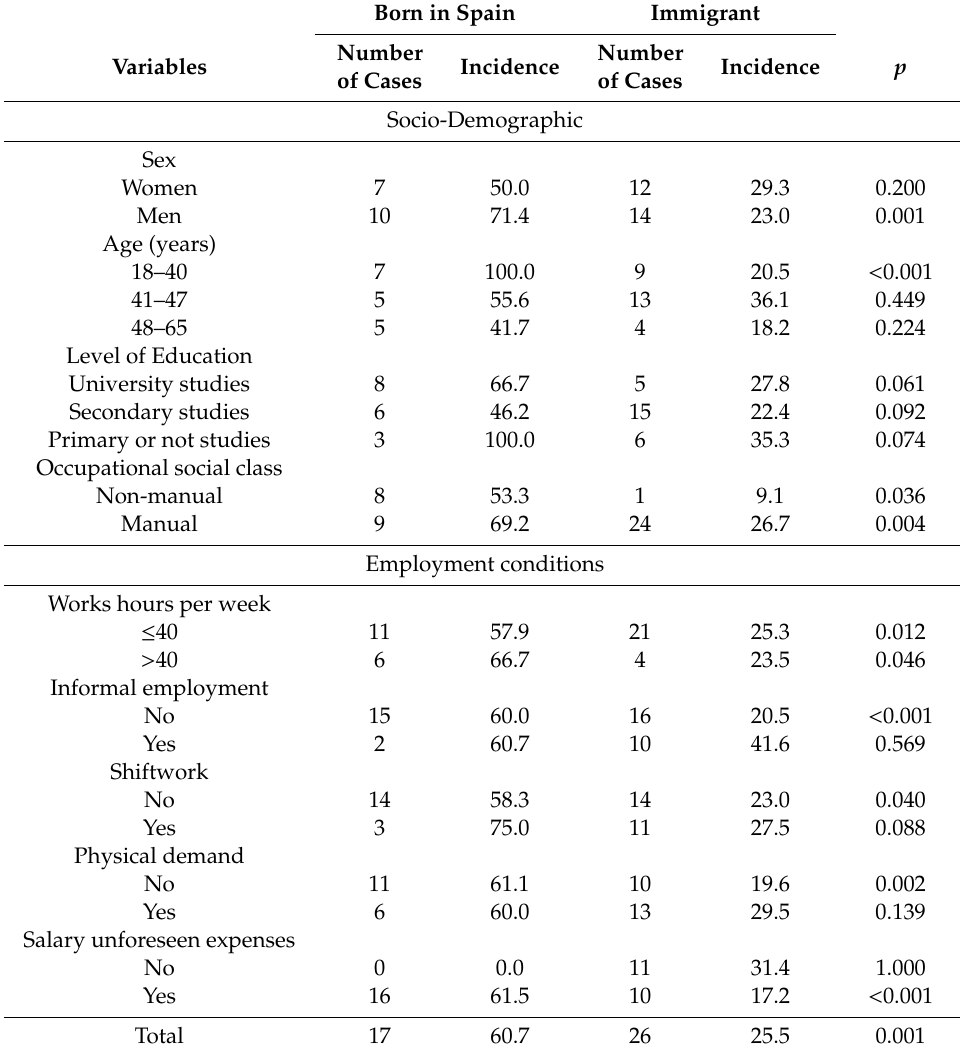
Table 2. Number and incidence of common mental disorders by socio-demographic characteristics, employment conditions, and migratory